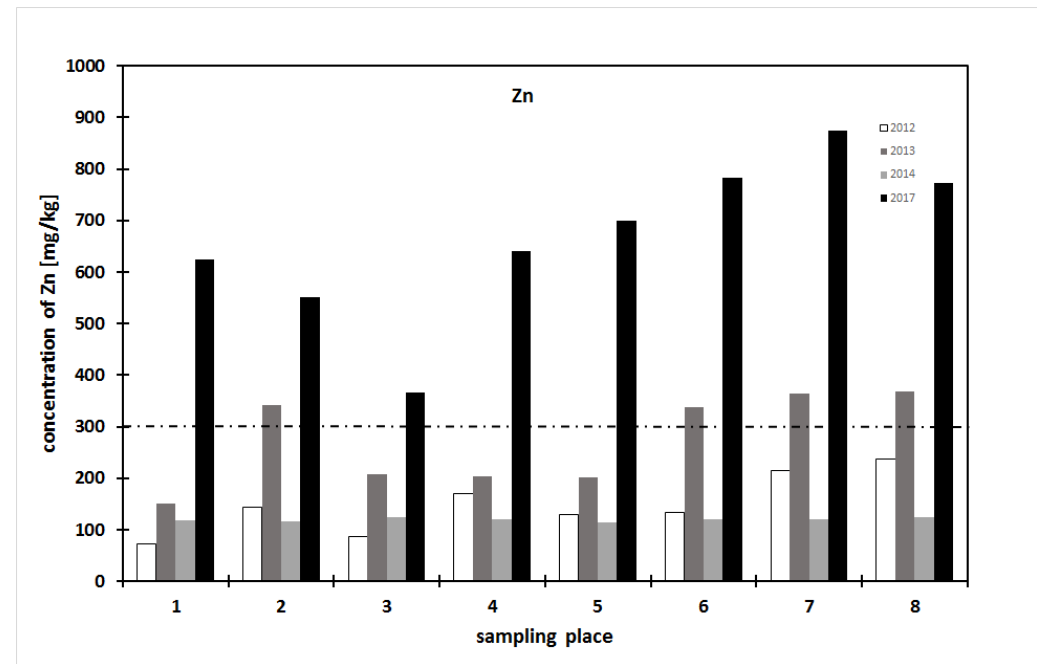
Figure 5. Content of Pb at individual sampling places in 2012, 2013, 2014, and 2017. The dashed line represents the limits for risk elements according to Annex No. 1 of the Czech Decree 257/2009 Coll. [30] . Limit of quantification <3 mg/kg.